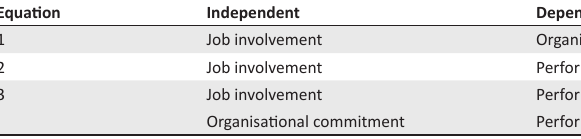
TABLE 2: Mediation effect for organisational commitment. Equation